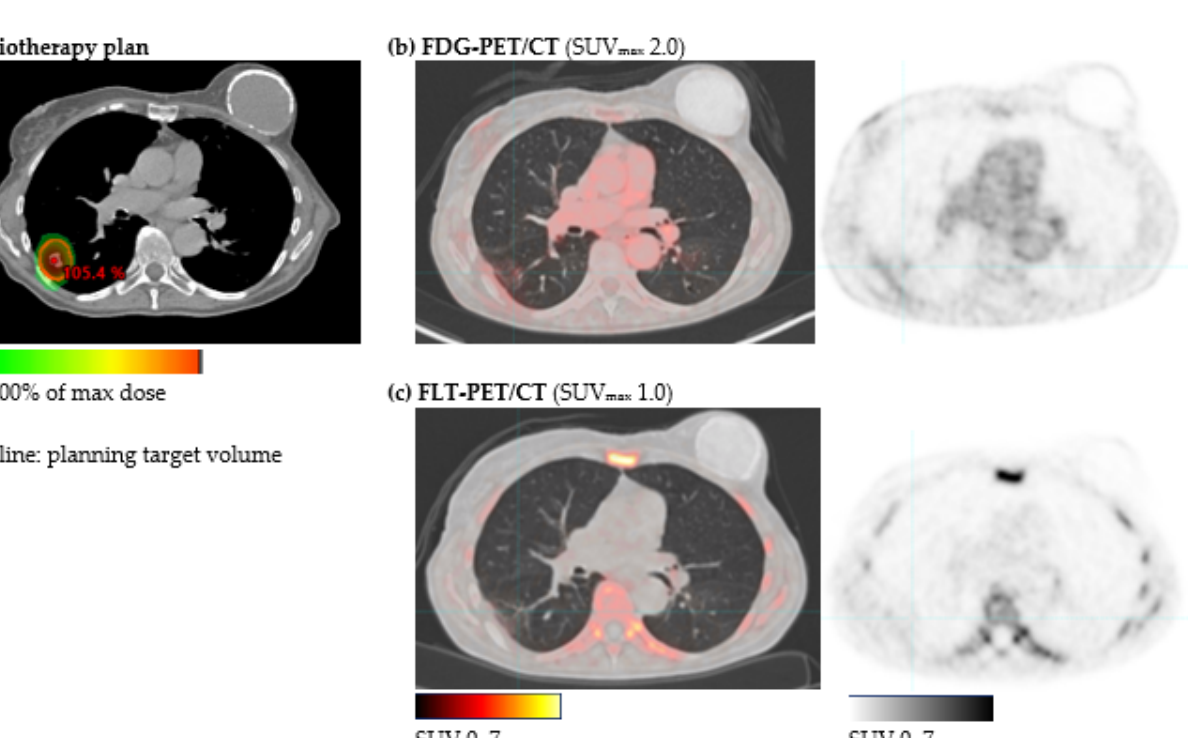
Figure 2. Patient with radiation-induced changes in HDV. ( a ) HDV defined as volume irradiated with >50% of max from the radiotherapy plan. The patient received SBRT (22 Gy × 3) for a T1N0M0 tumor in the right lower lobe. ( b ) FDG-PET/CT and ( c ) FLT-PET/CT 13 months after the end of radiotherapy showed only a faint shadow of FDG- and FLT-uptake in the HDV.